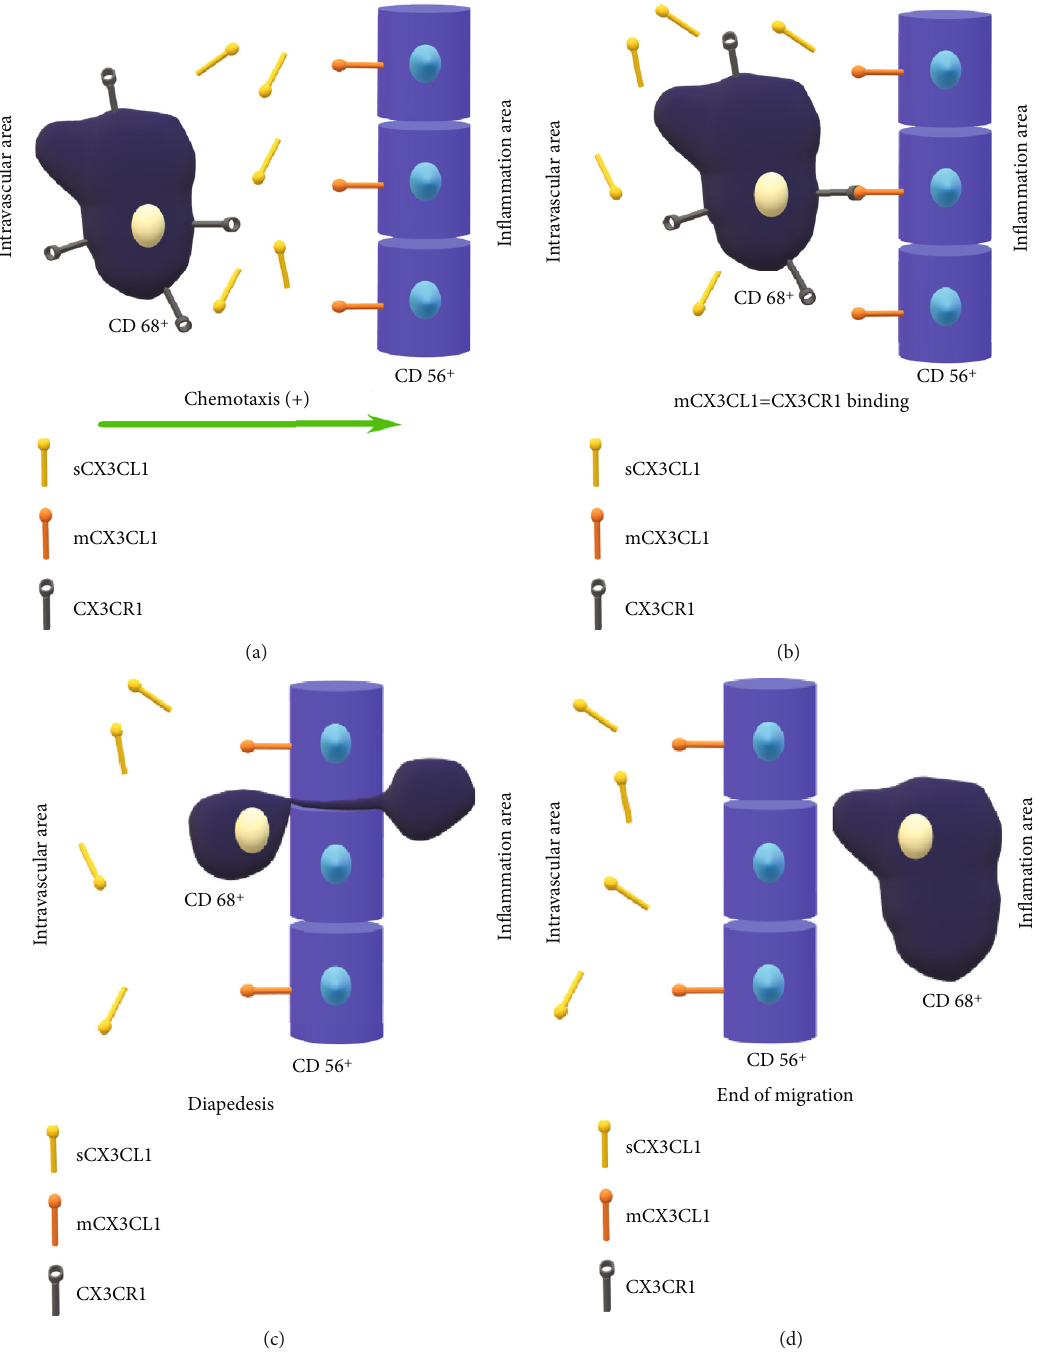
Figure 2: Schematic diagram showing the migration process of CX3CR1 + cells (in this case CD68 + cell) from the intravascular area via the vascular endothelium (CD56 + cells) to the site of in fl ammation. The chemotaxis process is initiated by the increasing concentration of sCX3CL1 (a). CD68 + cell moves towards endothelium cells that present mCX3CL1 on their surface (b). Binding of the CX3CR1 to mCX3CL1 begins the reaction cycle allowing the CD68 + to start the diapedesis process (c). The end of the migration process occurs when CD68 + is outside of the blood vessel (d). CX3CR1: CX3C chemokine receptor 1; CD: cluster of di ff erentiation; sCX3CL1: soluble form of CX3CL1; mCX3CL1: membrane-anchored form of